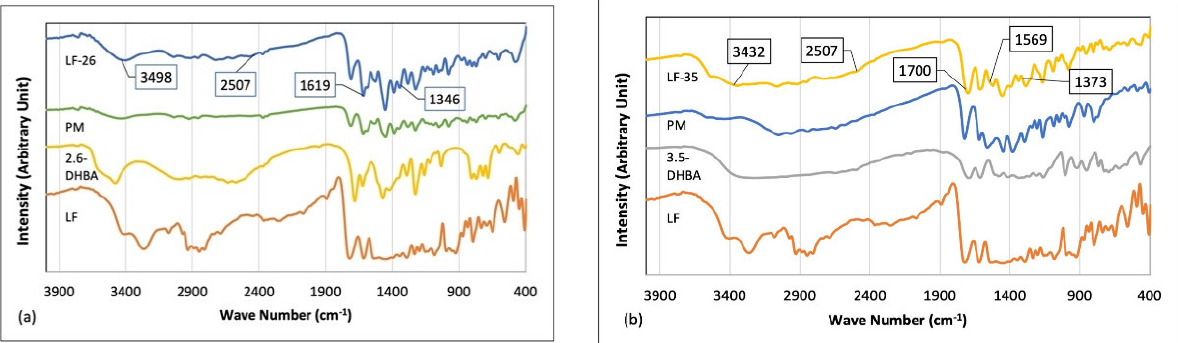
Figure 5. FTIR spectra comparison of the physical mixture and its multicomponent system: ( a ) LF-2,6-DHBA; ( b ) LF-3,5-DHBA. Note: LF = levofloxacin; DHBA = dihydroxybenzoic acid; PM = physical mixture.